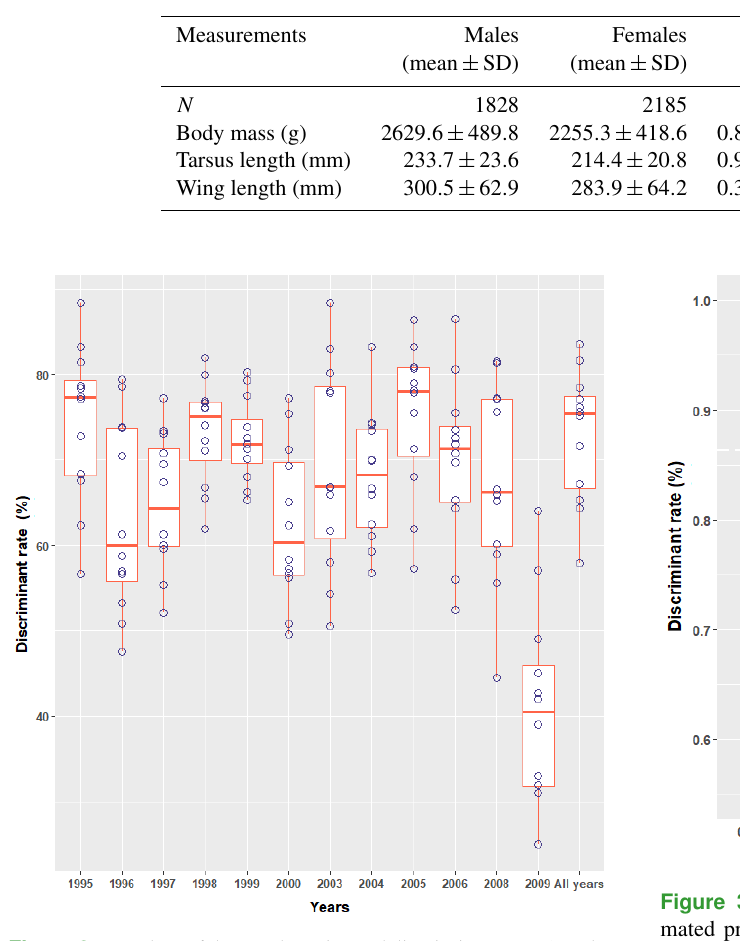
Figure 2. Boxplots of the yearly estimated discriminant rate (results of yearly DFA formulas validated on 11 different cohorts (1995– 2008, except 2001, 2002 and 2007)).